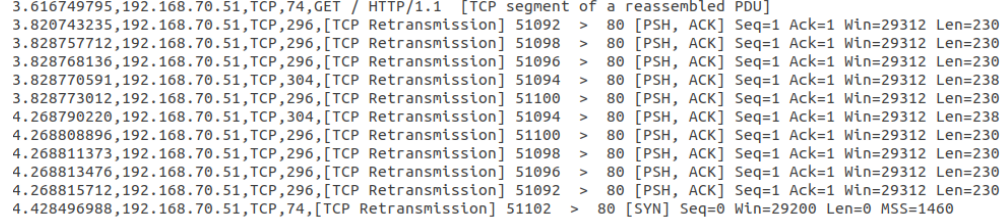
Figure 2. Slowloris attack traffic.